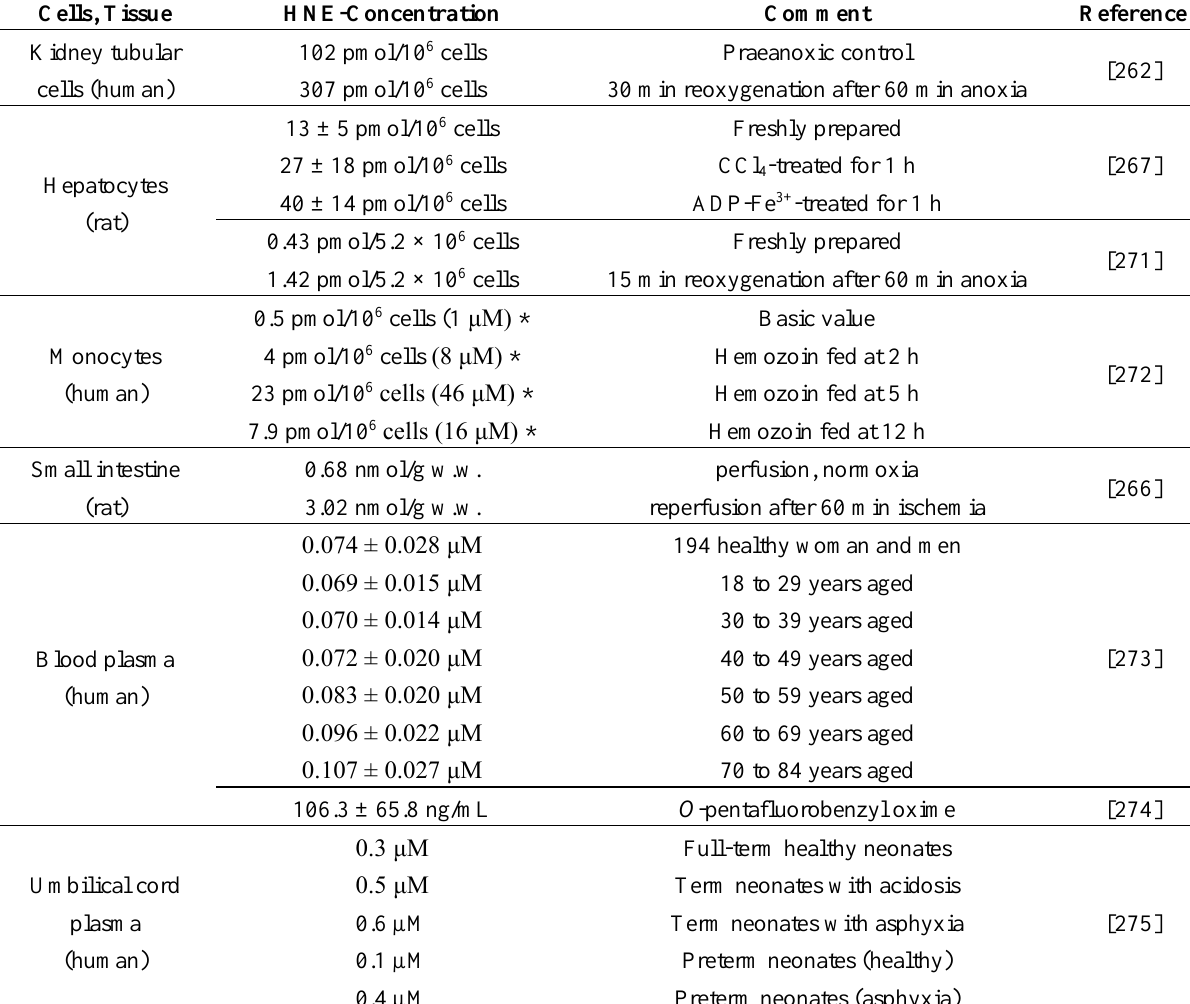
Table 1. HNE concentrations in cells, tissues and